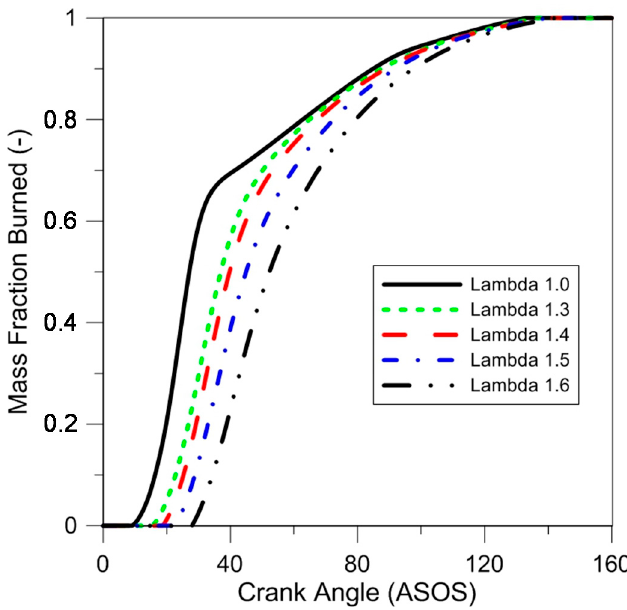
Figure 8. Mass fraction burned traces averaged over 200 consecutive cycles for each tested air–fuel ratio.